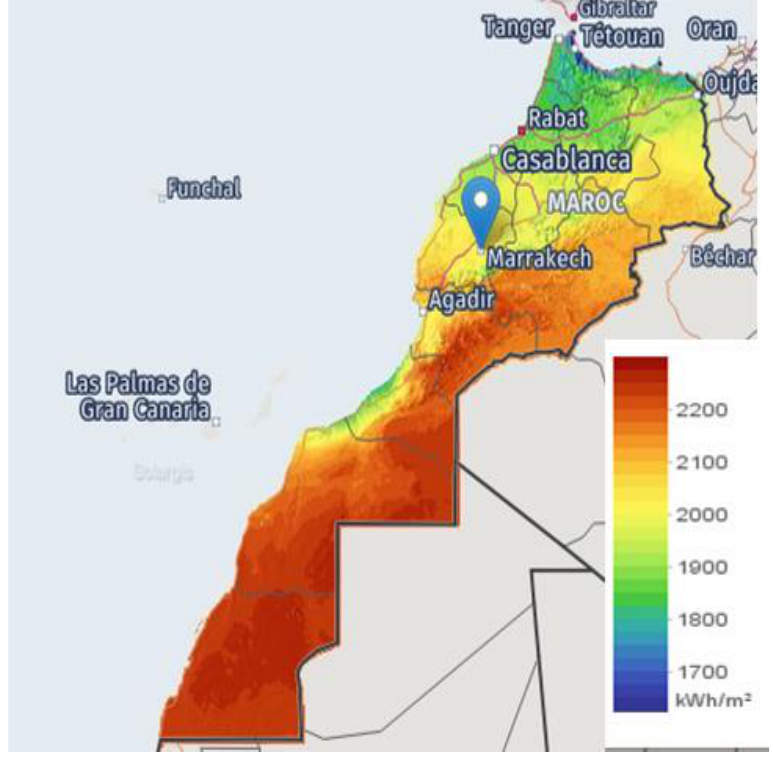
Figure 6. Moroccan solar potential [36].